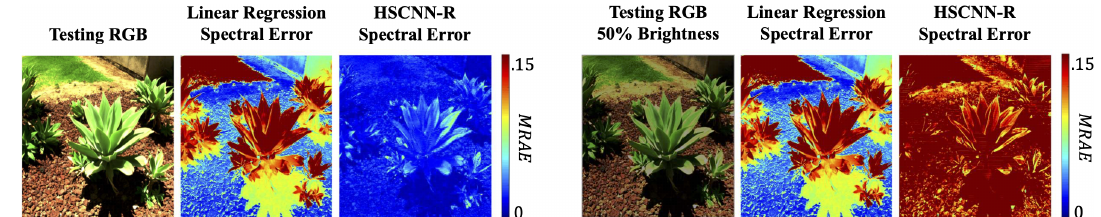
Figure 3. Spectral reconstruction under varying exposure by linear regression [33] and HSCNN-R [46]. The spectral errors are calculated in mean relative absolute error (MRAE)